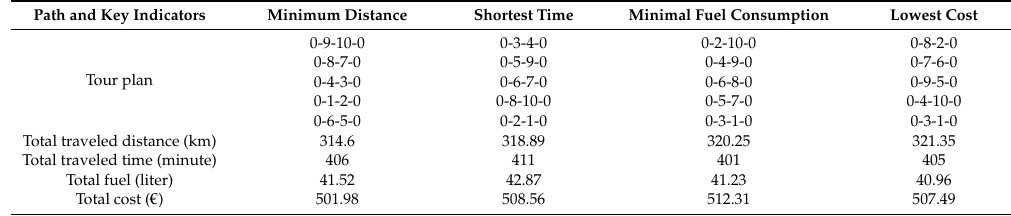
Table 5. Examples of di ff erent objective functions with no time-window constraints at 11 nodes.